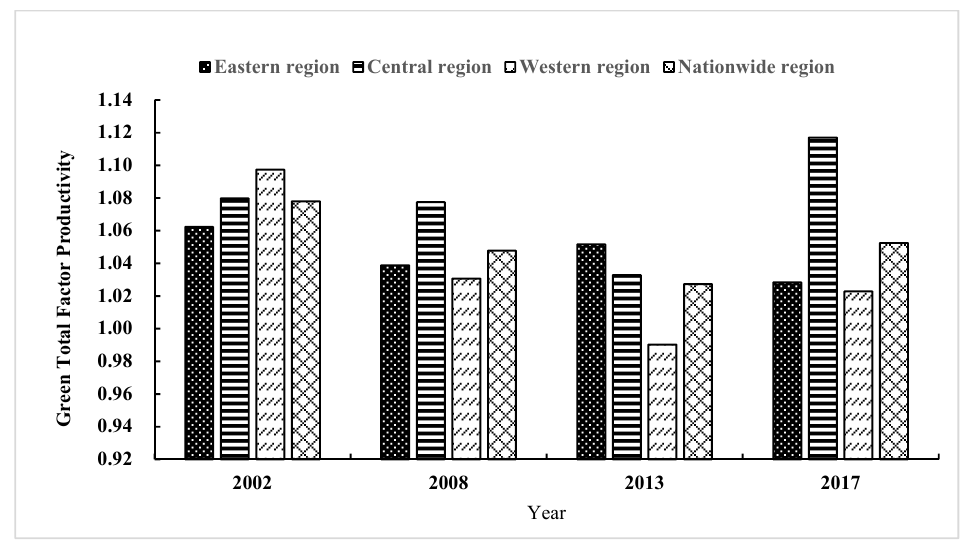
Figure 5. Changing trends in green total factor productivity (GTFP) by region.